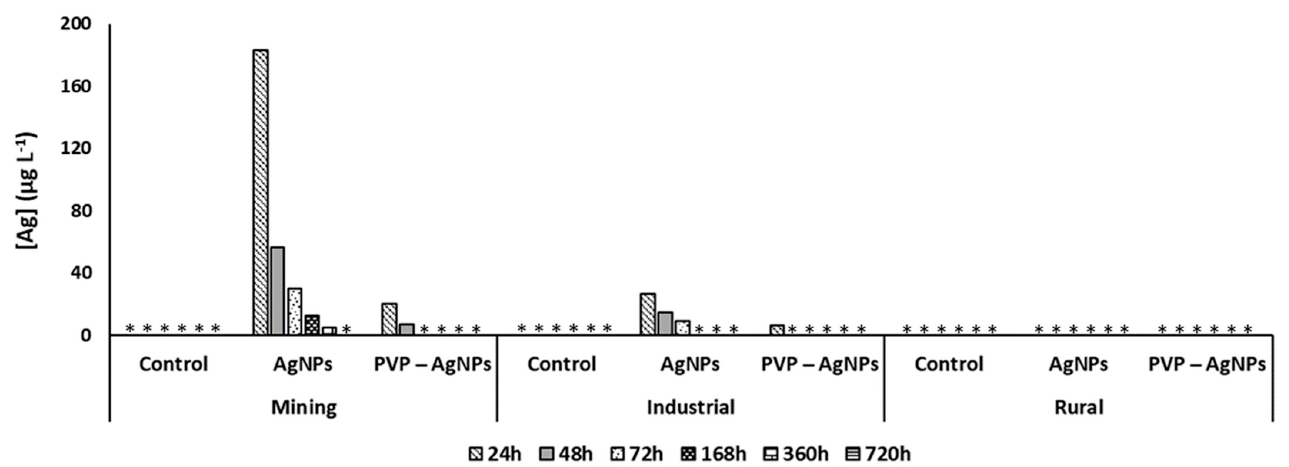
Figure 2. Silver content in surface (SF) pore water samples during the 720 h of study for control, and AgNPs and PVP-AgNPs soil amendment in soils from mining, industrial and rural area. (*) below the limit of quantification.